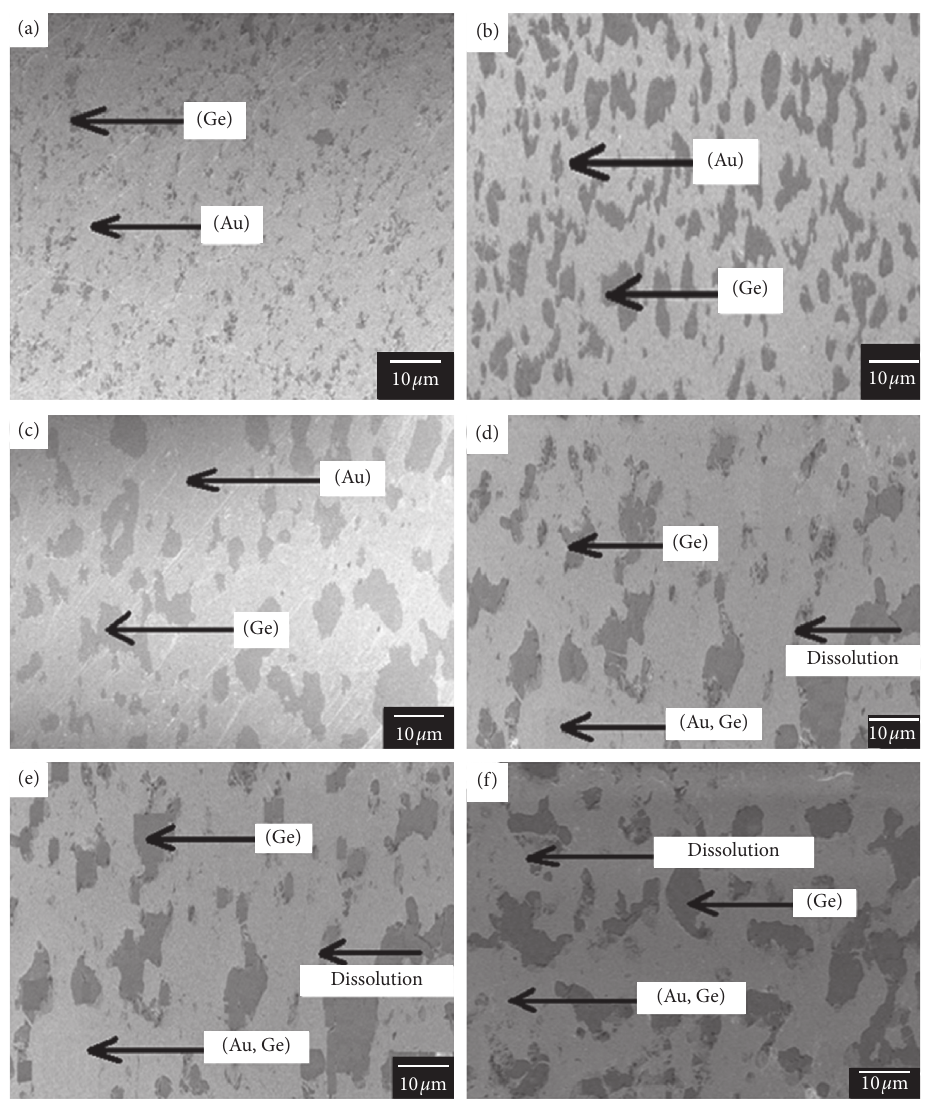
Figure 6: SEM secondary electron imaging (SEI) micrographs of Au-Ge eutectic alloy: (a) without thermal aging and after (b) 100h, (c) 200h, (d) 300h, (e) 400h, and (f) 500 h of thermal aging at 300 ° C [47].